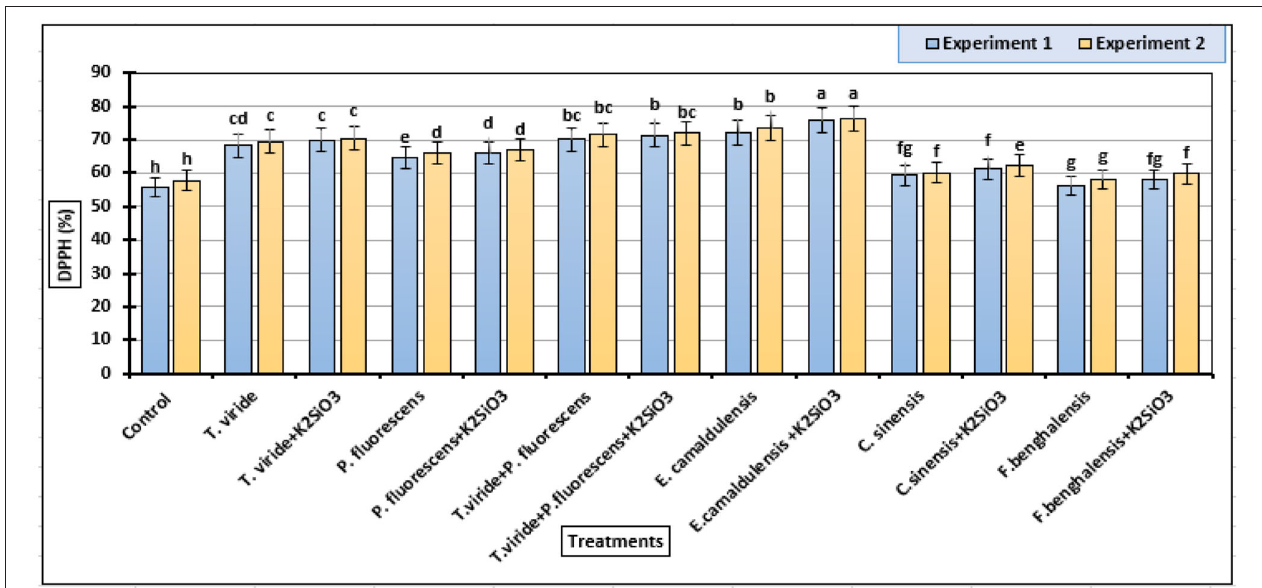
FIGURE 4 | DPPH (2,2-diphenyl-1-picrylhydrazyl) inhibition percentages (means ± S.E) of methanol extracts from zucchini fruits as affected by the plant extracts, microbial inoculations, and potassium silicate biostimulants. Letters in the figure indicated that means ± S.E of treatments with the same letter/s were not significantly different according to Tukey’s HSD at a 0.05 level of